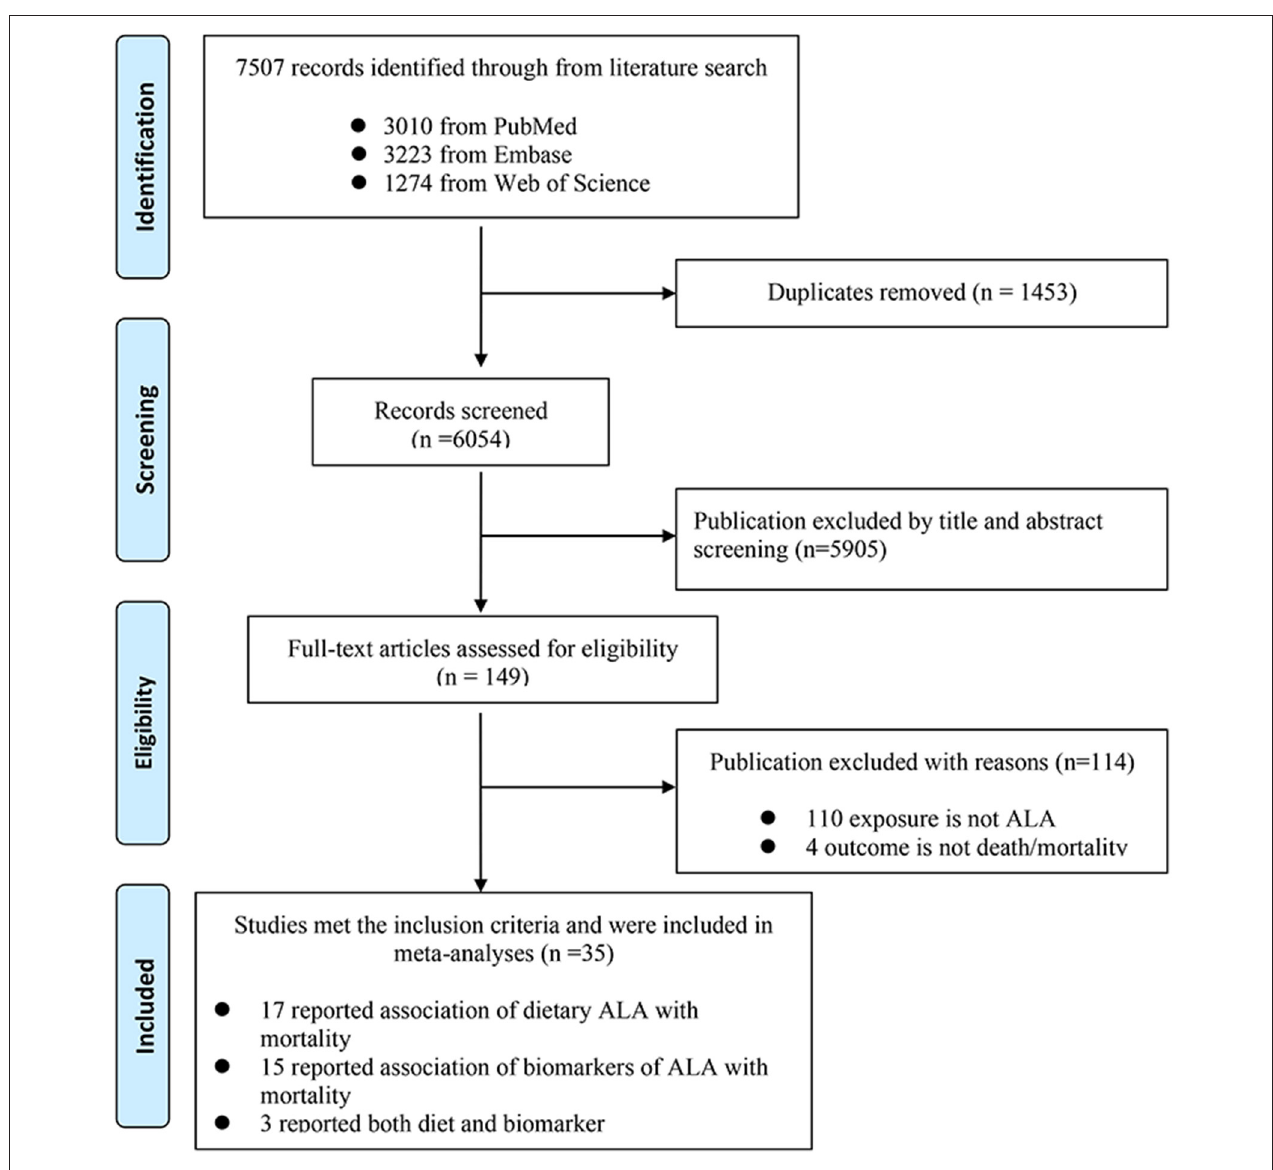
FIGURE 1 | Flow chart of study